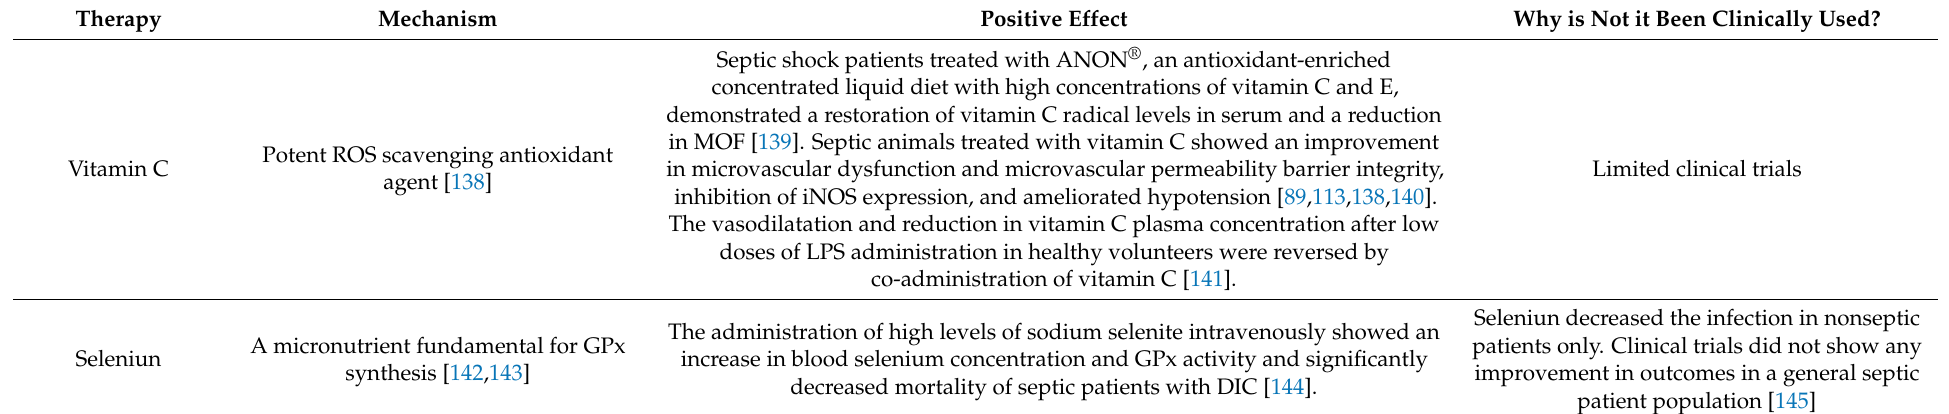
Table 2. Potential antioxidant